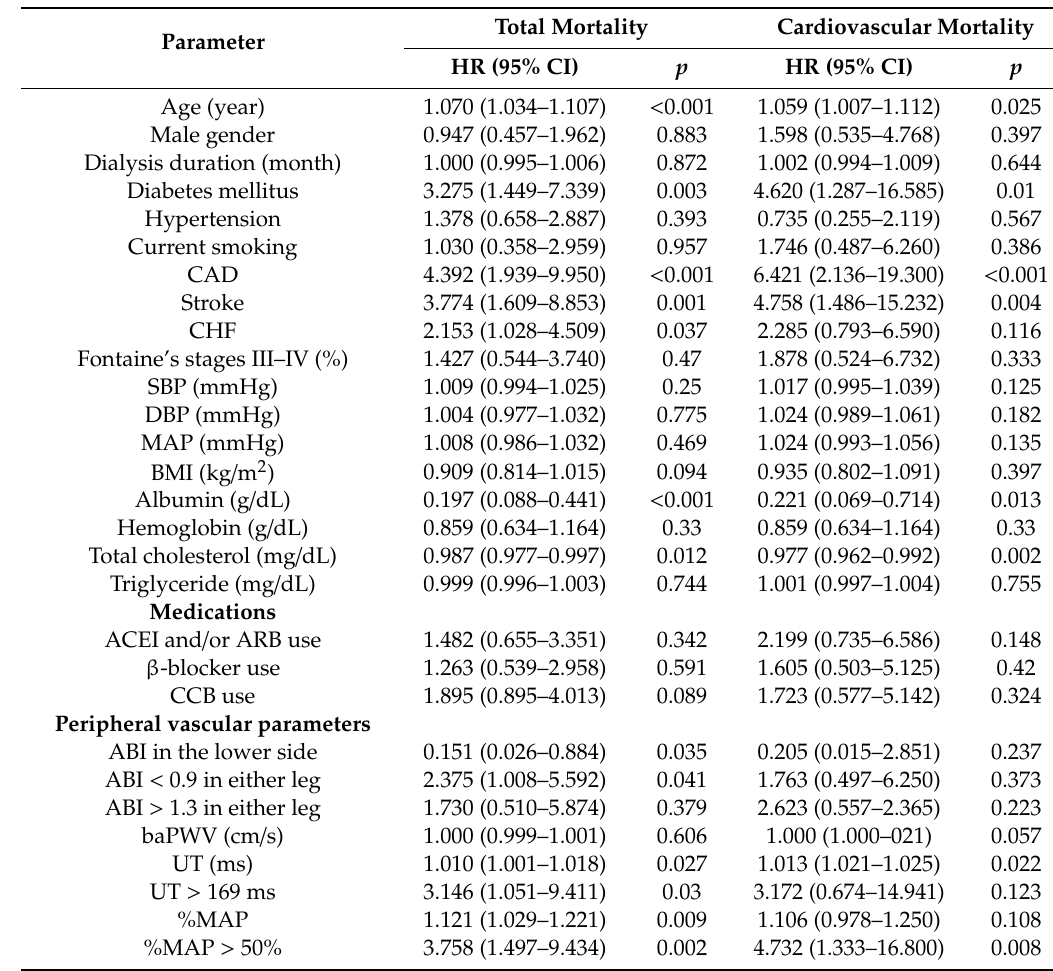
Table 4. Predictors of total and cardiovascular mortality using the Cox proportional hazards model in the univariate analysis.